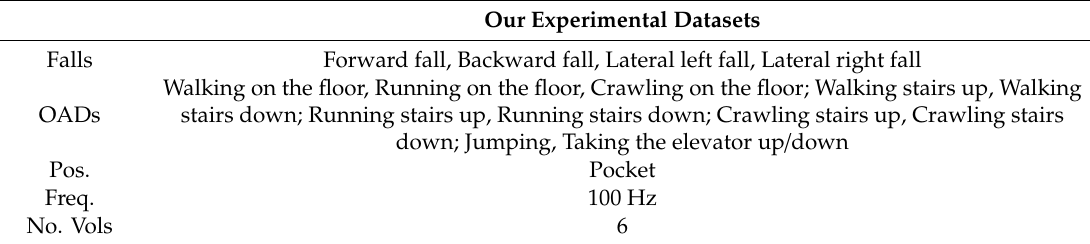
Table 6. The features of our experimental